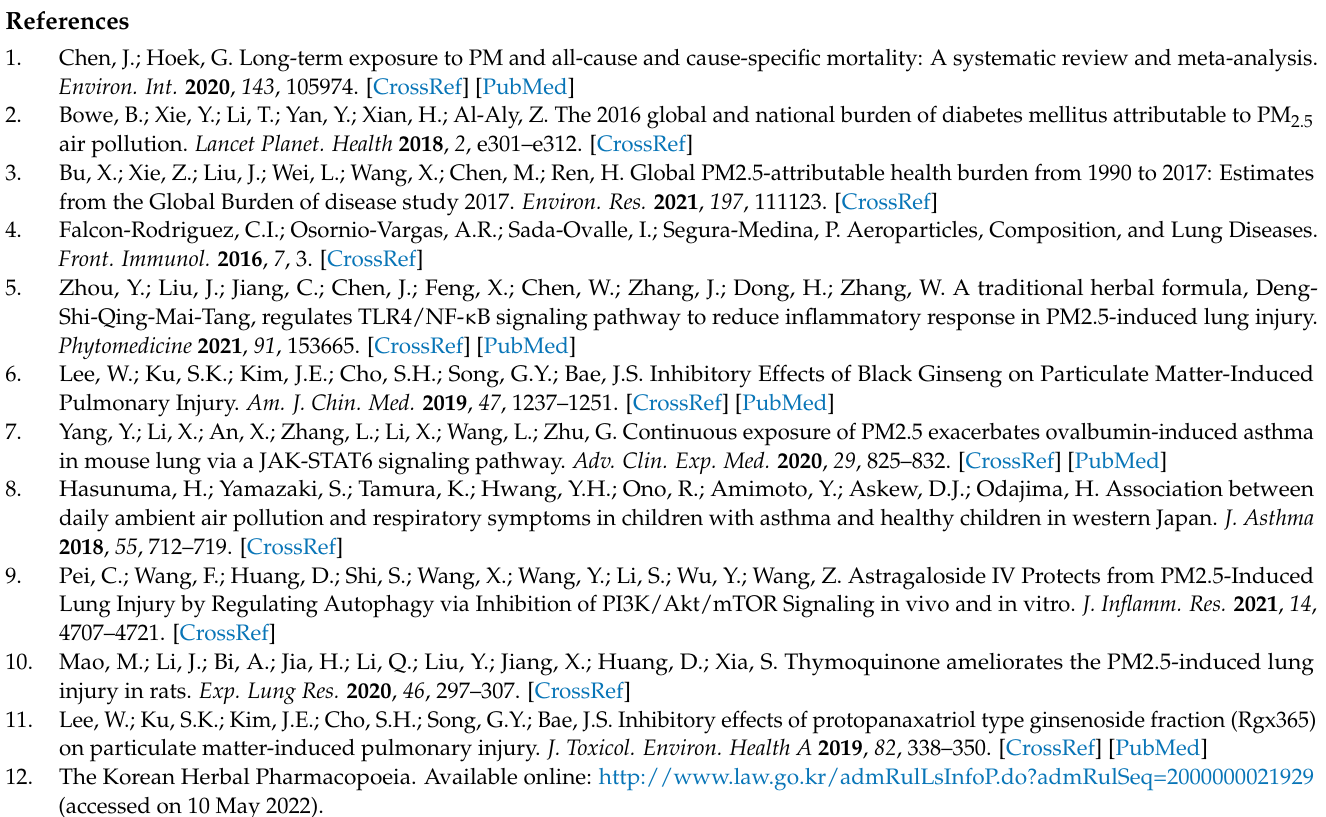
by PM 2.5 ; Figure S2: AsE promotes phlegm excretion; Figure S3: AsE protects A549 cells from oxidative